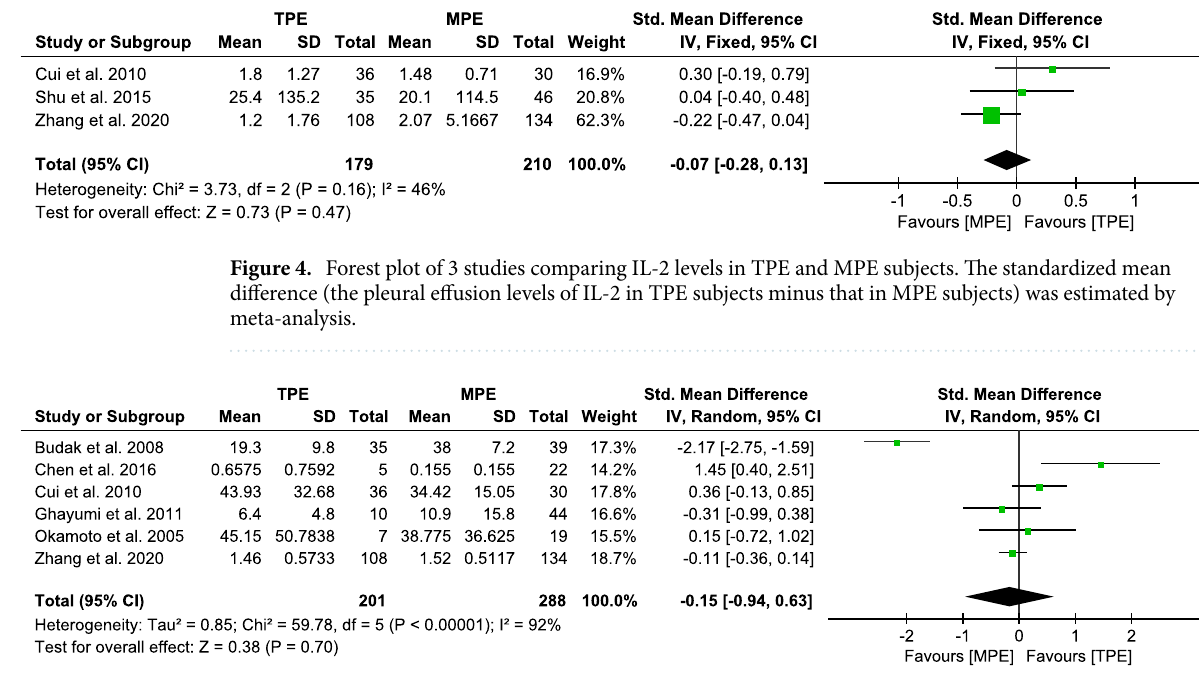
Figure 5. Forest plot of 6 studies comparing IL-4 levels in TPE and MPE subjects. The standardized mean difference (the pleural effusion levels of IL-4 in TPE subjects minus that in MPE subjects) was estimated by